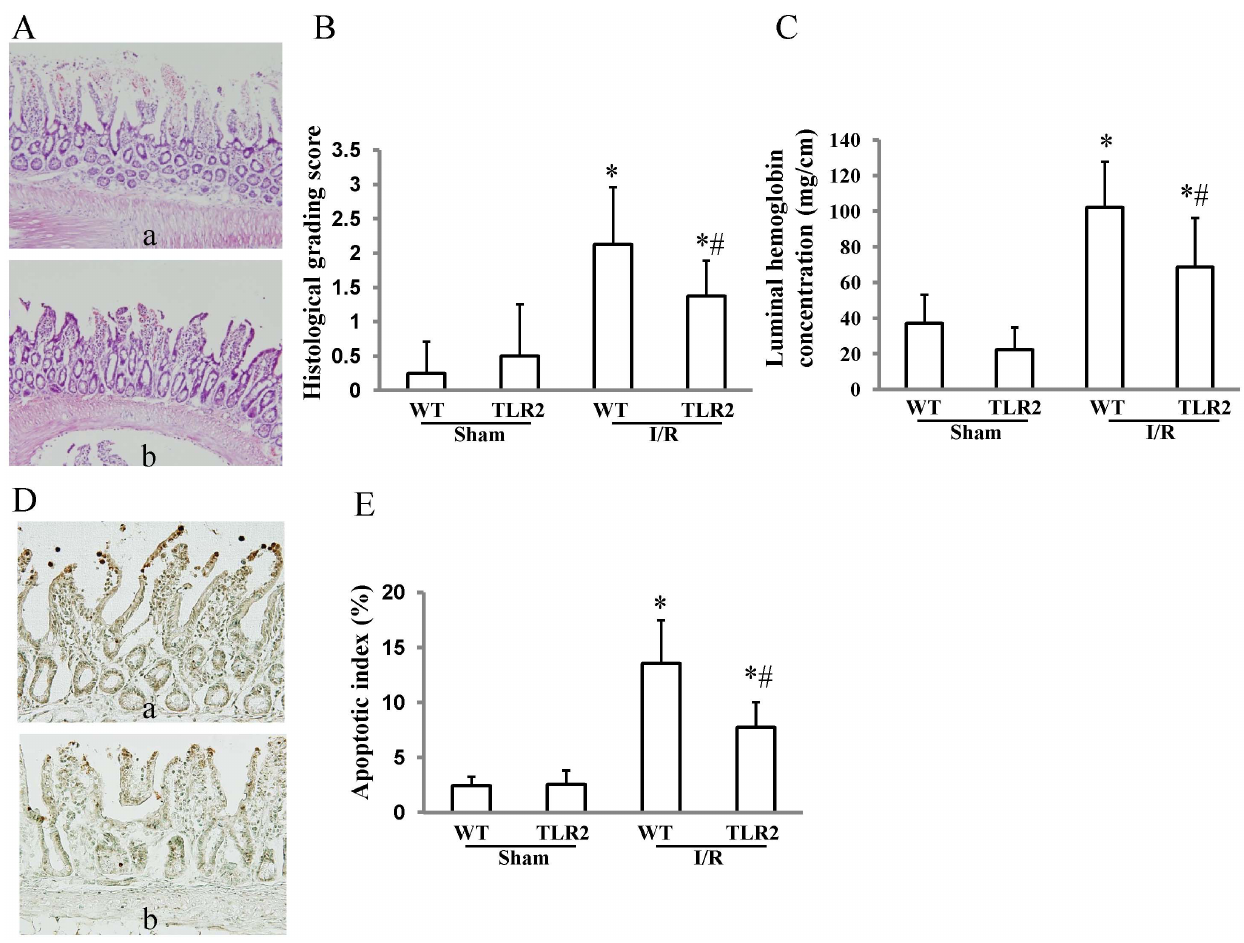
Figure 1. Effect of TLR2 deficiency on intestinal ischemia/reperfusion injury. Wild-type (WT) mice and TLR2 knockout (KO) mice were subjected to 45 min of ischemia followed by 60 min of reperfusion. After removal of the small intestine, intestinal injuries were assessed by using the histological grading system, measuring the luminal hemoglobin concentration, and counting apoptotic epithelial cells with an antibody against ssDNA. (A) Histological findings of intestinal ischemia/reperfusion (I/R) injury in WT (a) and TLR2 KO (b) mice. Compared to WT mice (a), TLR2 KO mice exhibited less severe intestinal injury induced by 45 min of ischemia followed by 60 min of reperfusion (b). (B) Comparison of the histology grading scores between WT and TLR2 KO mice that were subjected to I/R injury. Each column represents the mean 6 SD. N=8. * P , 0.01 vs WT mice with sham operation, # P , 0.05 vs WT mice subjected to I/R injury. (C) Comparison of luminal hemoglobin concentrations between WT and TLR2 KO mice that were subjected to I/R injury. Each column represents the mean 6 SD. N=6–8. * P , 0.01 vs WT mice with sham operation, # P , 0.01 vs WT mice subjected to I/R injury. (D) Immunohistochemical staining of ssDNA in intestinal mucosa. I/R resulted in induction of apoptosis of epithelial cells labeled with an antibody against the ssDNA of injured mucosa in WT mice (a), and TLR2 deficiency prevented I/R-induced apoptosis of the small intestinal epithelial cells (b). (E) Comparison of apoptotic indices between WT and TLR2 KO mice that were subjected to I/R injury. Each column represents the mean 6 SD. N=8. * P , 0.01 vs WT mice with sham operation, # P , 0.01 vs WT mice subjected to I/R